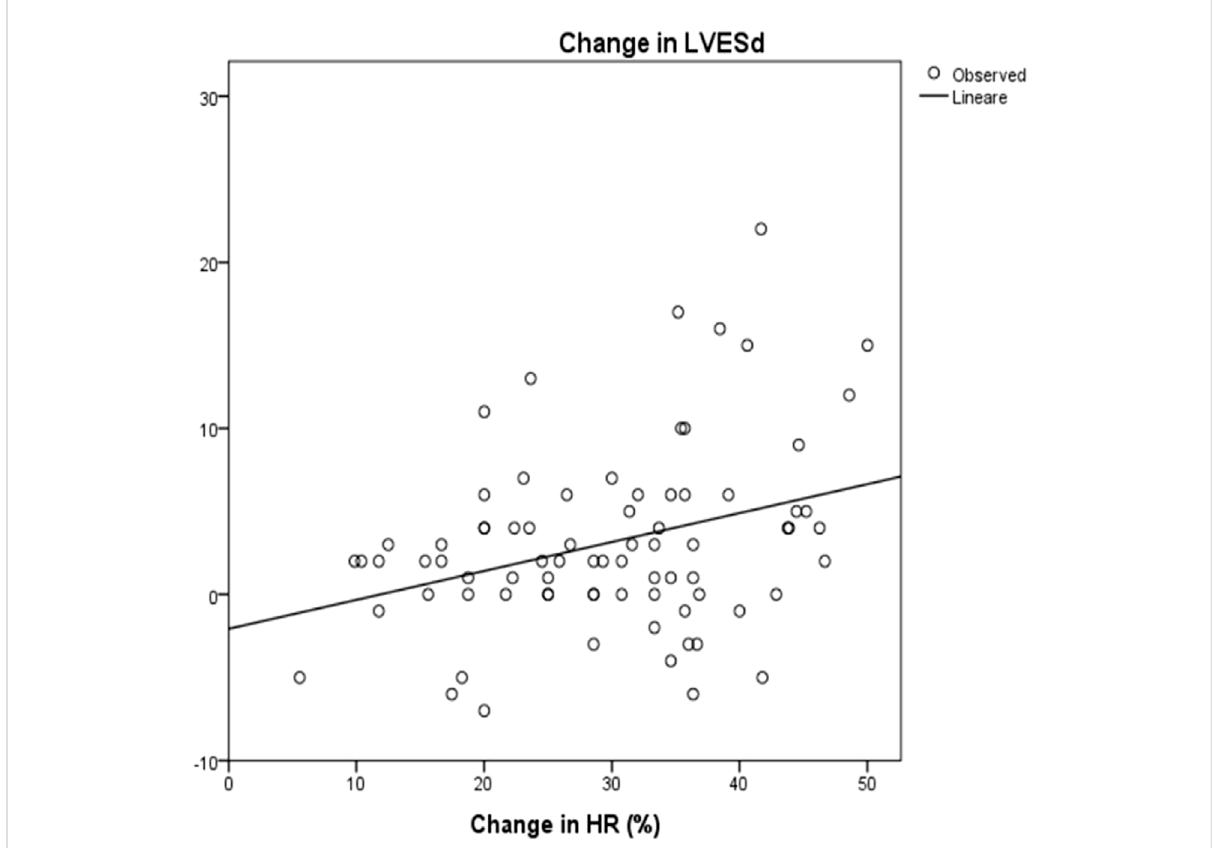
FIGURE 5 Correlation between change in HR and change in LVESd: R2 0.1; p = 0.003 HR: Heart rate; LVESd: Left Ventricular End Systolic Diameter. The change in end systolic diameter was calculated between baseline and after 3 years of follow up. The change in HR was calculated as the differences between baseline and at the maximum dose of